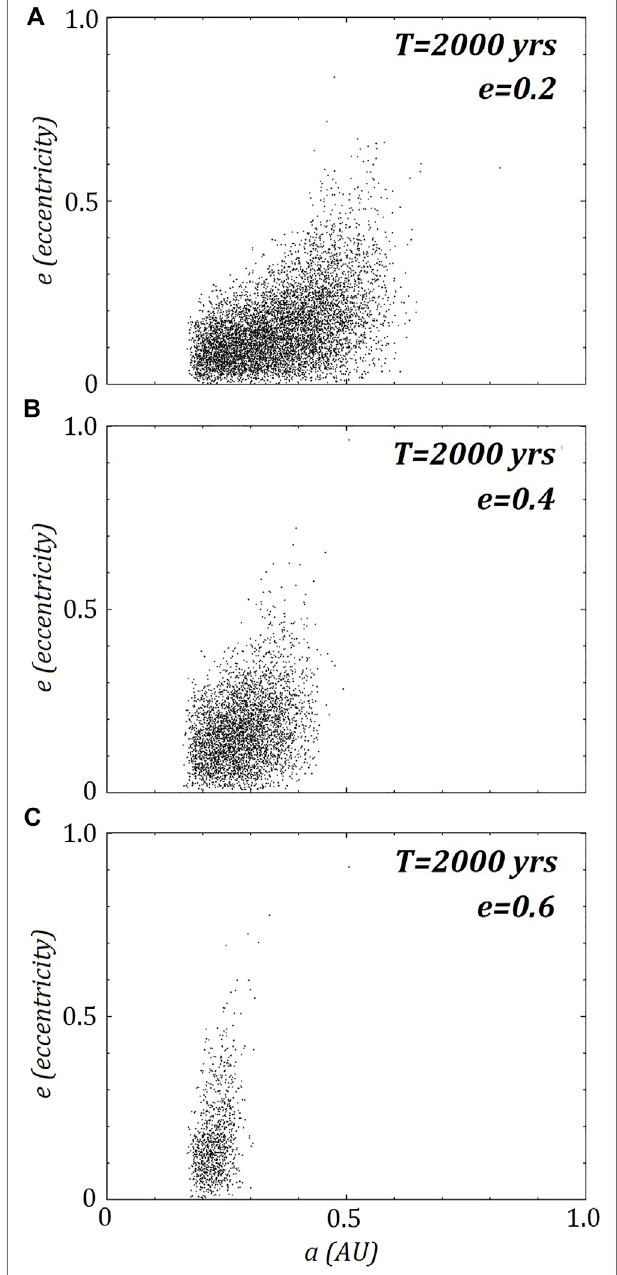
FIGURE 12 | he same three retrograde ring models (A) e = 0.2, (B) e = 0.4 and (C) e = 0.6 are shown in Figure 5 with their calculated eccentricities and semi-major axis for all ring particles after 2000 years or ~182 orbits about the